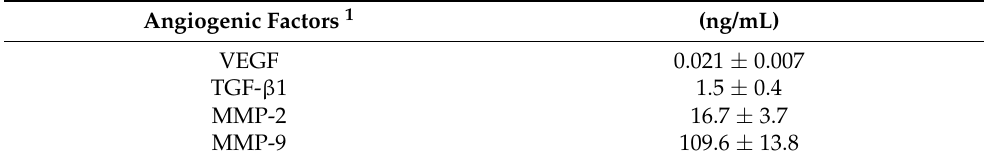
Table 3. Angiogenic factors released by CGF-derived